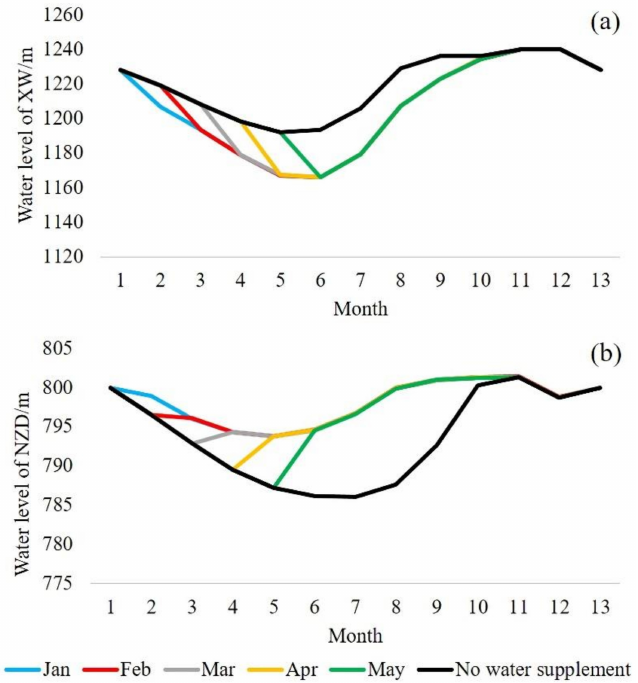
Figure 9. The water level processes of XW ( a ) and NZD ( b ) under the limit state of water supplement in 1983 (dry year, P =